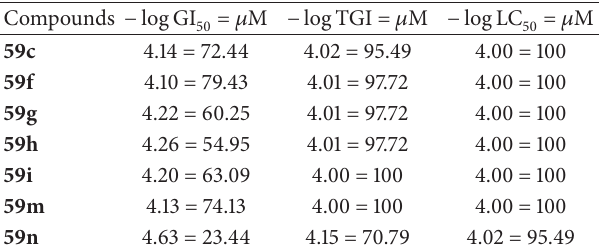
Table 10: − log GI , − log TGI, and − log LC 50 points (MG-MID) a of in vitro inhibitory activity against human tumor cell lines b